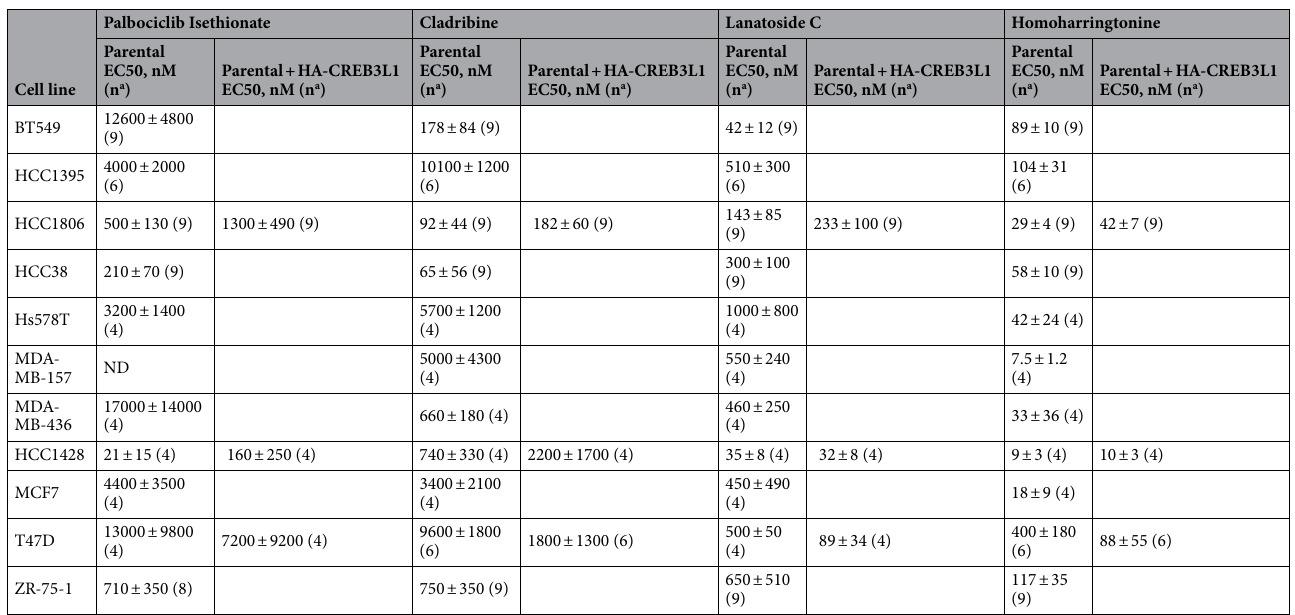
Table 2. EC50 values across multiple CREB3L1-deficient TNBC and luminal A breast cancer cell lines. n, number of replicate measurements. a Cell viability was determined over a range of drug concentrations after 4 days of drug treatment and EC 50 values were determined.